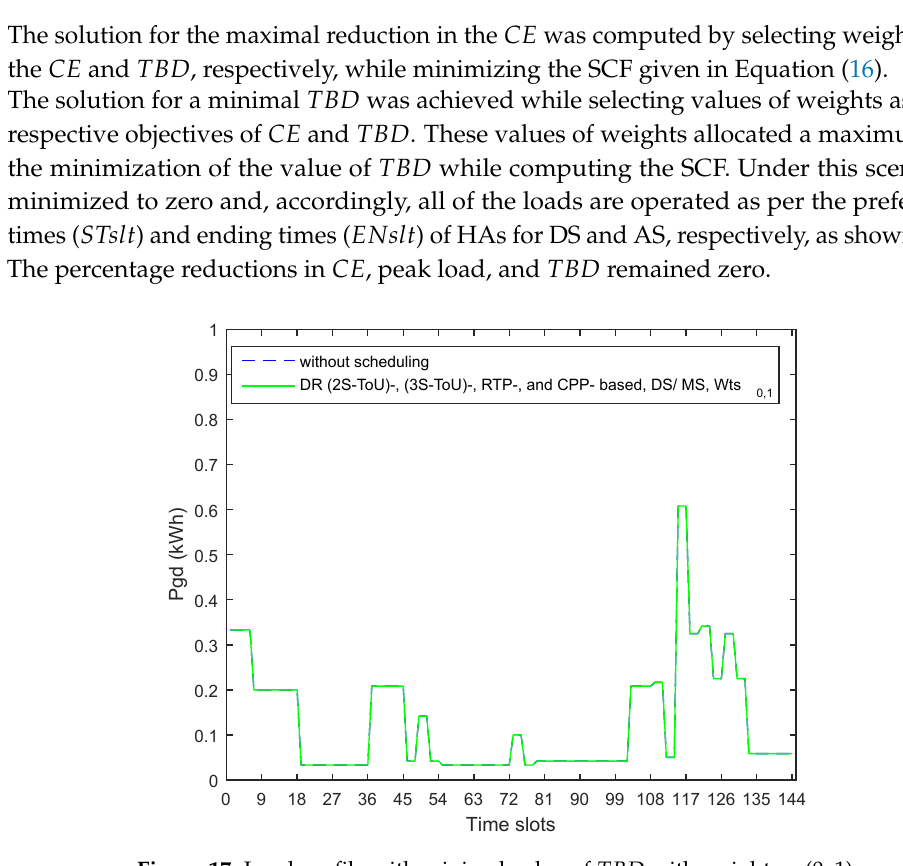
Figure 17. Load profile with minimal value of TBD with weights = (0,